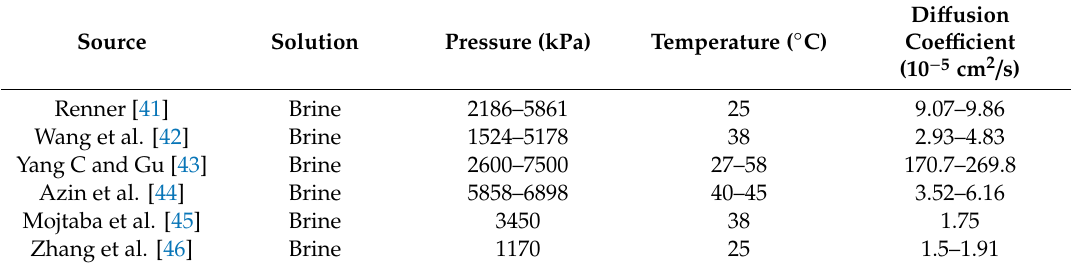
Table 5. CO 2 diffusion coefficients in brine as found in the